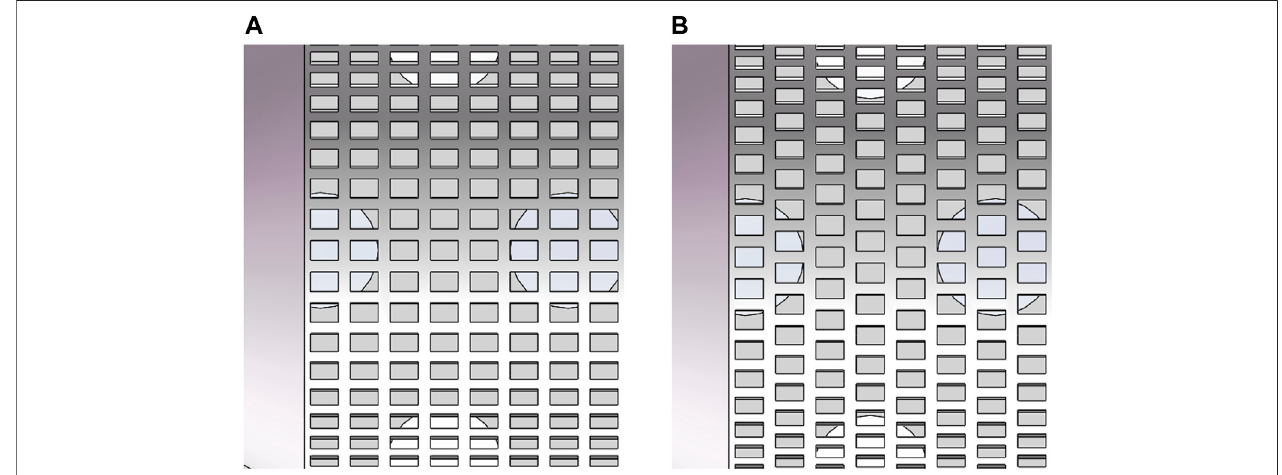
FIGURE 8 | Square hole arrangement. (A) Inline arrangement. (B) Staggered arrangement.